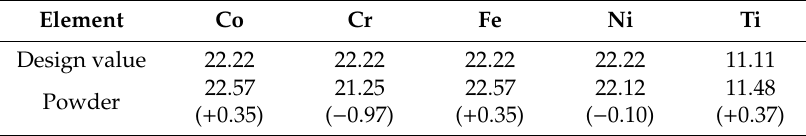
Table 1. Element Atomic Ratio of CoCrFeNiTi 0.5 HEA powder.